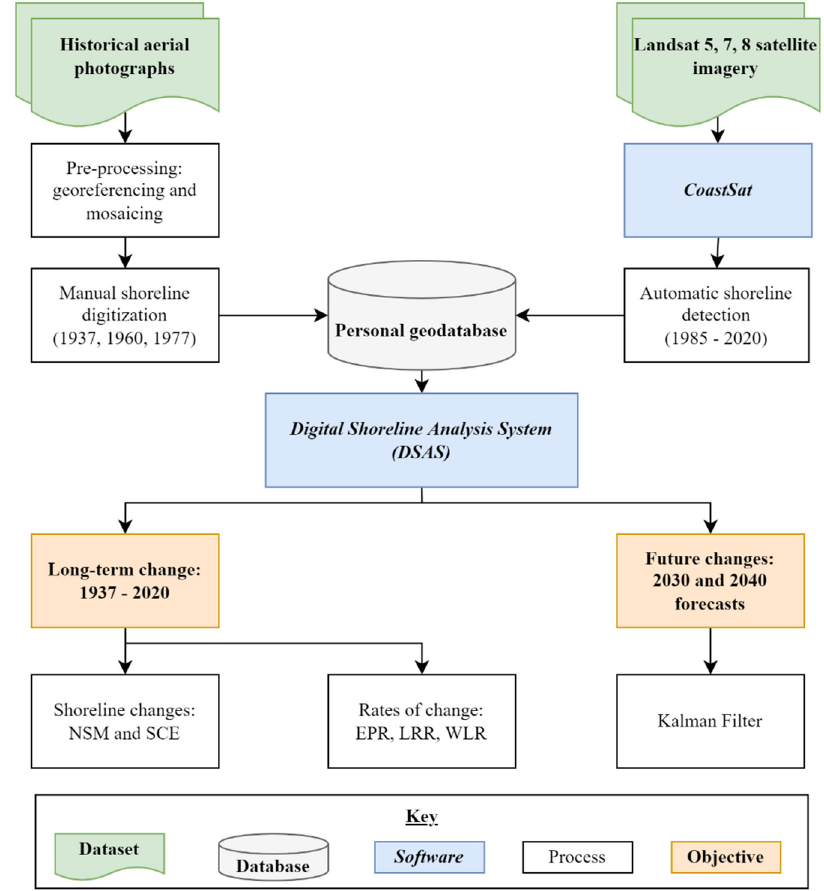
Figure 2. Flowchart of the overall methodology for assessing the shoreline changes.